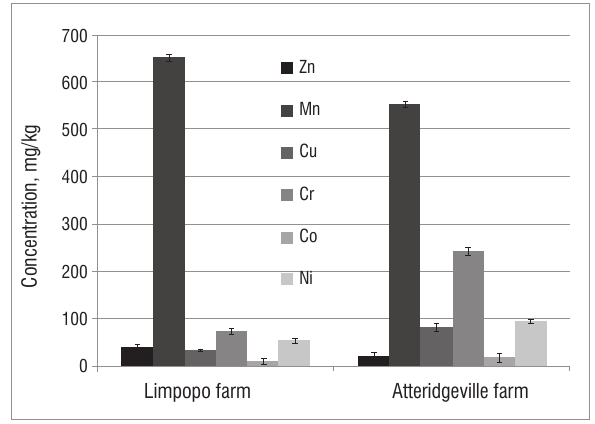
Figure 4: Average concentration of minor elements in soil samples from farms in the Limpopo and Atteridgeville. Results shown are means of triplicates; error bars represent %RSD